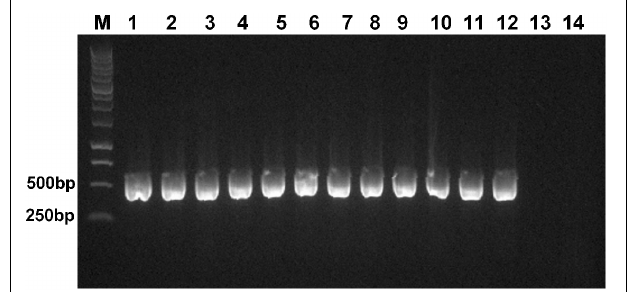
FIGURE 3 | Verification of the presence of Himar1 transposon cassette. Genomic DNA was extracted from 11 randomly picked A. actinomycetemcomitans transconjugants after seven serial passages. PCR was carried out using primers targeting the kanamycin resistance